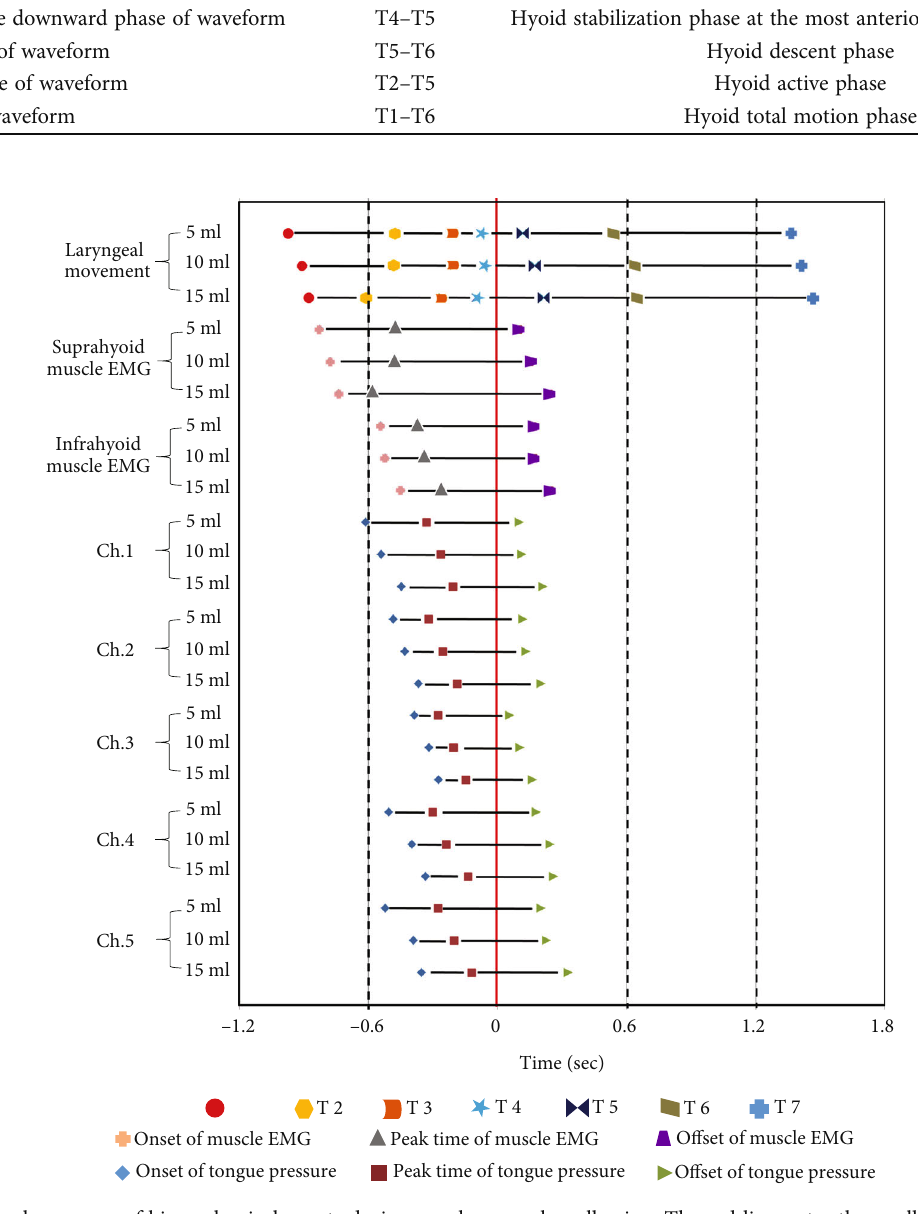
Figure 2: Temporal sequence of biomechanical events during oropharyngeal swallowing. The red line notes the swallowing sound as the reference time. T1, onset of hyoid slight movement; T2, onset of hyoid rapid movement; T4, onset of stationary phase of the hyoid; T5, o ff set of stationary phase of the hyoid; T6, o ff set of hyoid movement. T3 and T7 were con fi rmed to be meaningless for hyoid activity; Ch. 1 – Ch. 5, Channel 1 to Channel